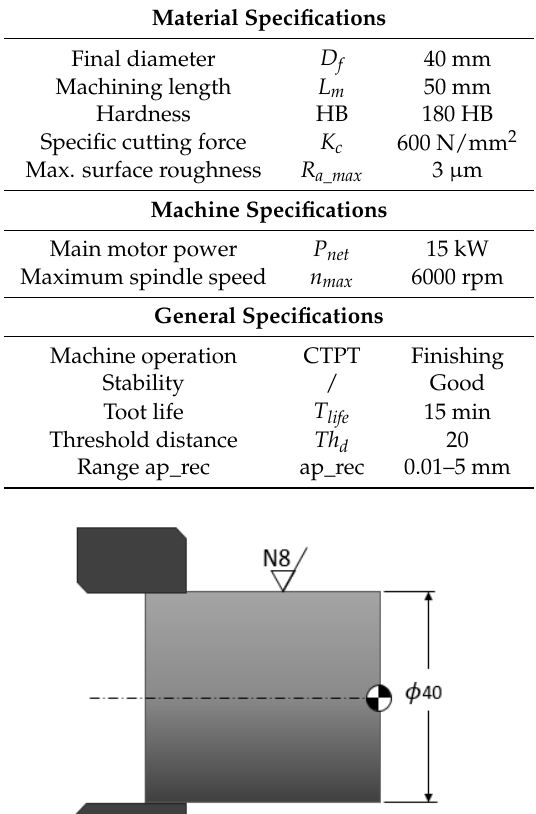
Table 15. Working specifications of the finishing operation example.